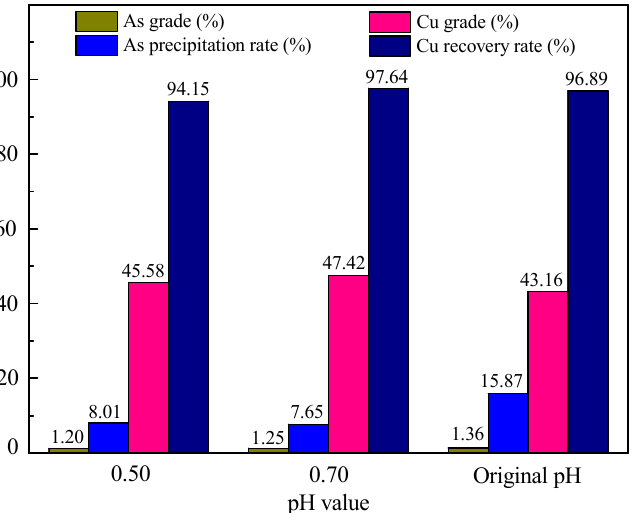
Figure 4. Effect of different pH values on copper selective recovery (molar ratio of SRSP to copper: 1:1, reaction time: 40 min). 1:1, reaction time: 40